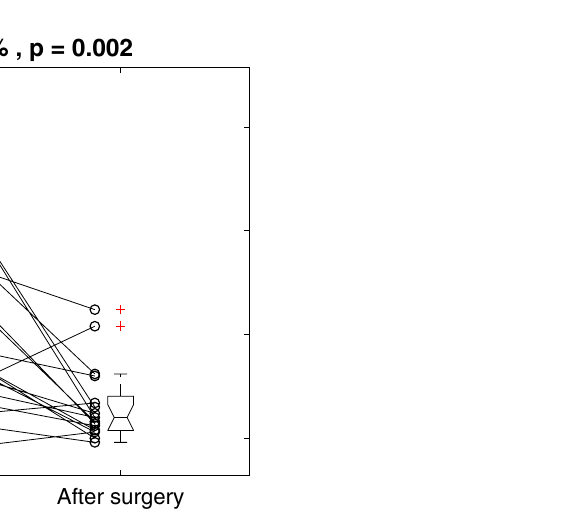
Figure 4. Individual mean desaturation before and after the